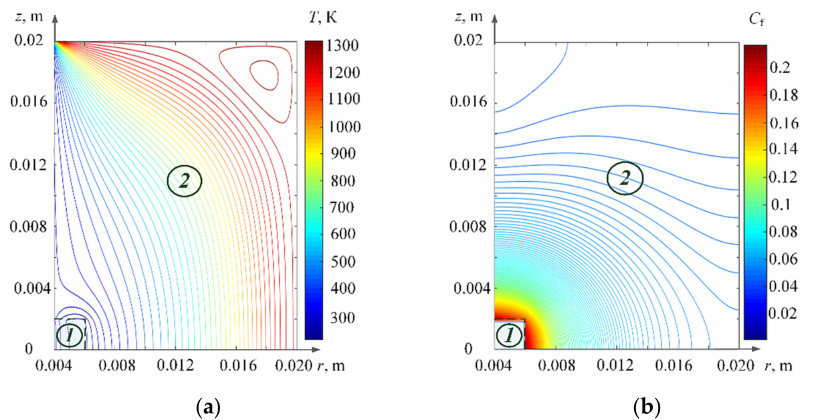
Figure 6. ( a ) Temperature field under radiant heating; ( b ) Field of relative concentrations of fuel vapors under radiant heating; 1—gel fuel sample, 2—steam–gas mixture. Conditions: T = 1273 K, ε = 0.85.